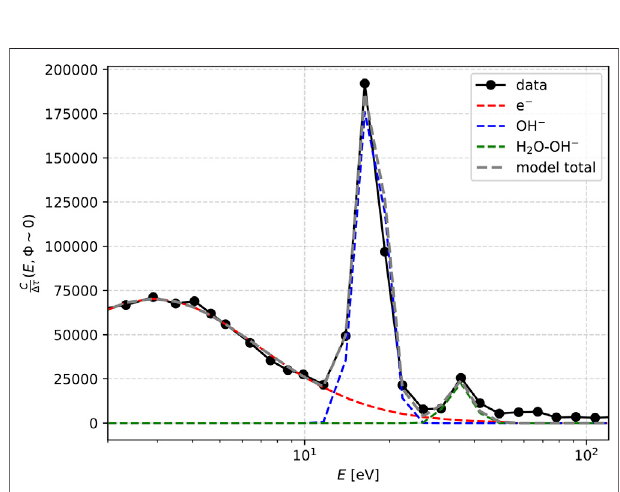
FIGURE 8 | Observations by CAPS compared with our model. With black, we show count rates as a function of energy, obtained at azimuth anode 5, which is nearly along the ram direction of the spacecraft, averaged over the four spectra indicated by the magenta square in Figure 7 . We show models for the plasma electrons (red), OH − (blue) and H 2 O-OH − (green) ions. The grey curve corresponds to the sum of the modeled count rates. We assume that all species are stationary, therefore resolved due to the spacecraft